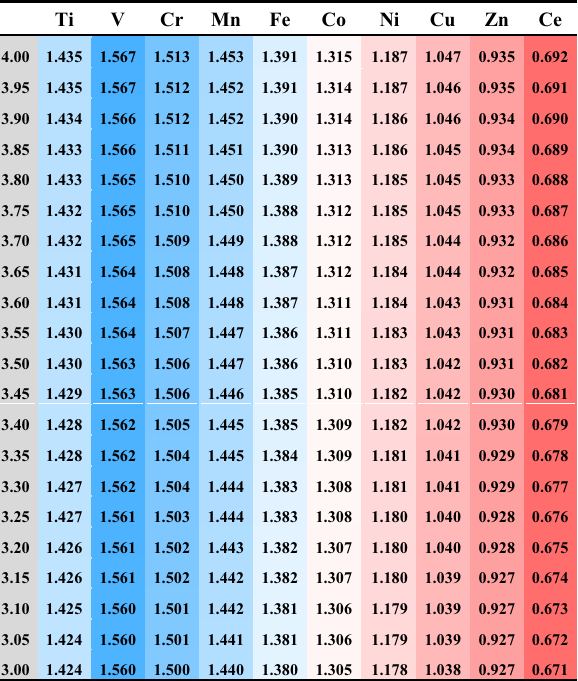
Table 1. The BOP table for the M@Ce 12 O 8 36+ cluster models (M = Ti, V, Cr, Mn, Fe, Co, Ni, Cu, Zn, Ce). The maximum value (1.967) is set to blue and the minimum value (0.671) to red. Each cell is colored by gradient according to the obtained BOP values, blue for larger and red for smaller values.